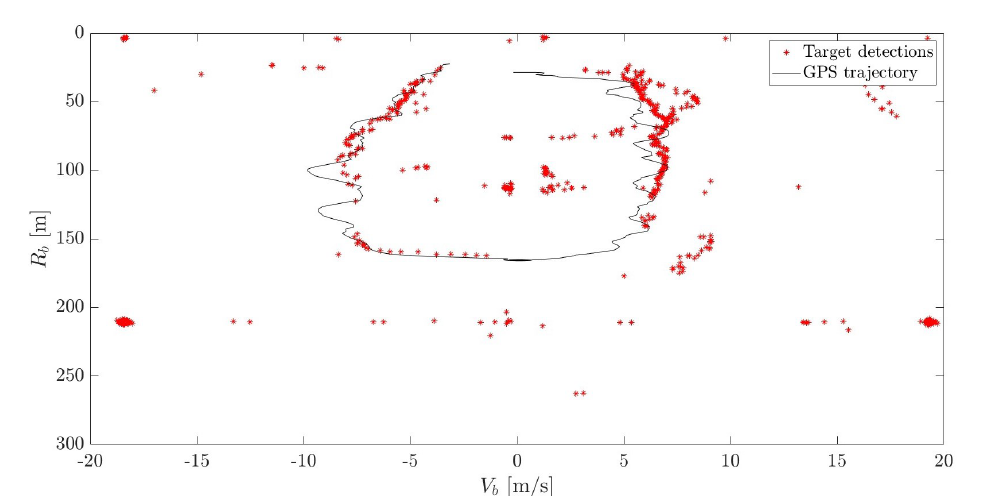
Figure 23. Detection of 1 minute of the drone flight.